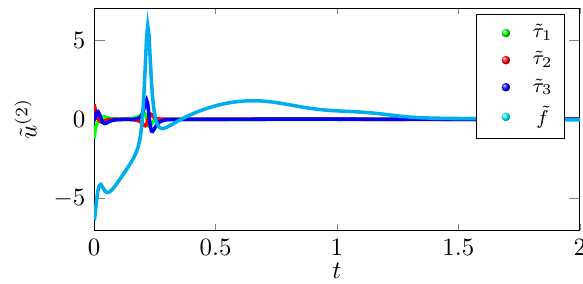
Figure 4. Optimal tracking control law ˜ u ( 2 )